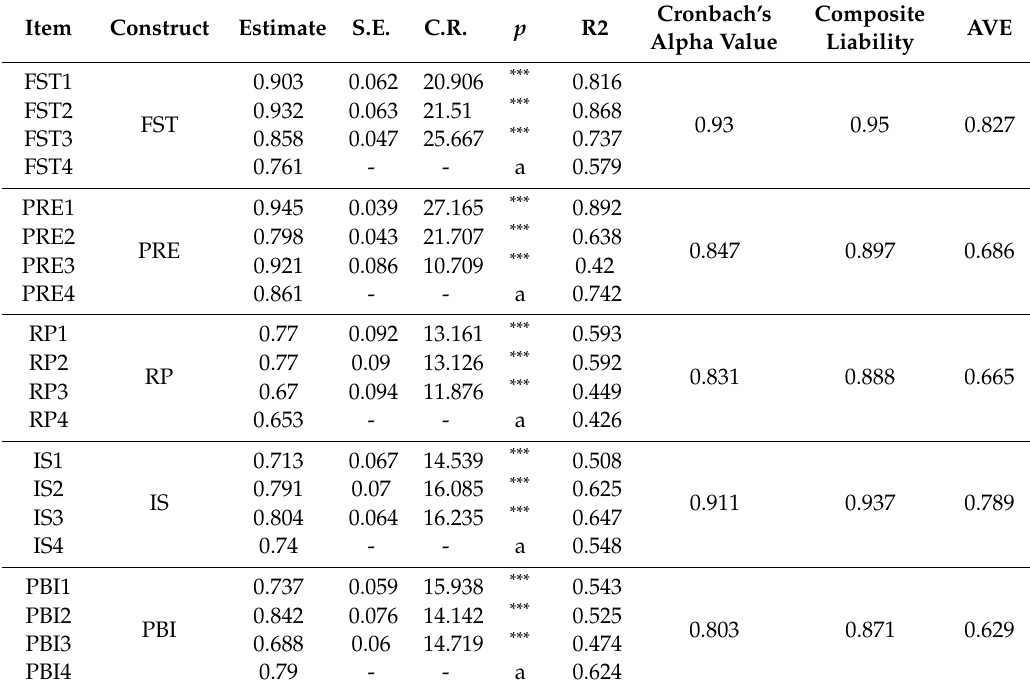
Table 2. Measurement model (confirmatory factor analysis (CFA)) results.